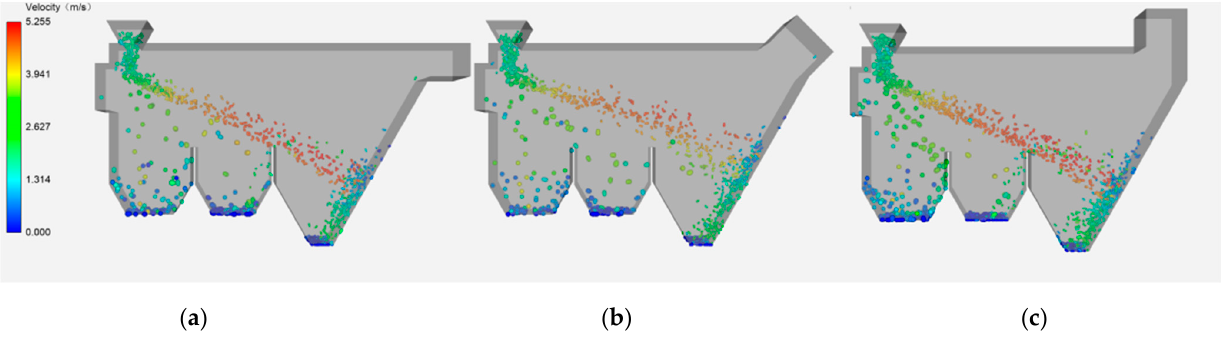
Figure 19. Particle motion of different types of dust remover angles: ( a ) 0 ◦ ; ( b ) 45 ◦ ; ( c ) 90 ◦ .